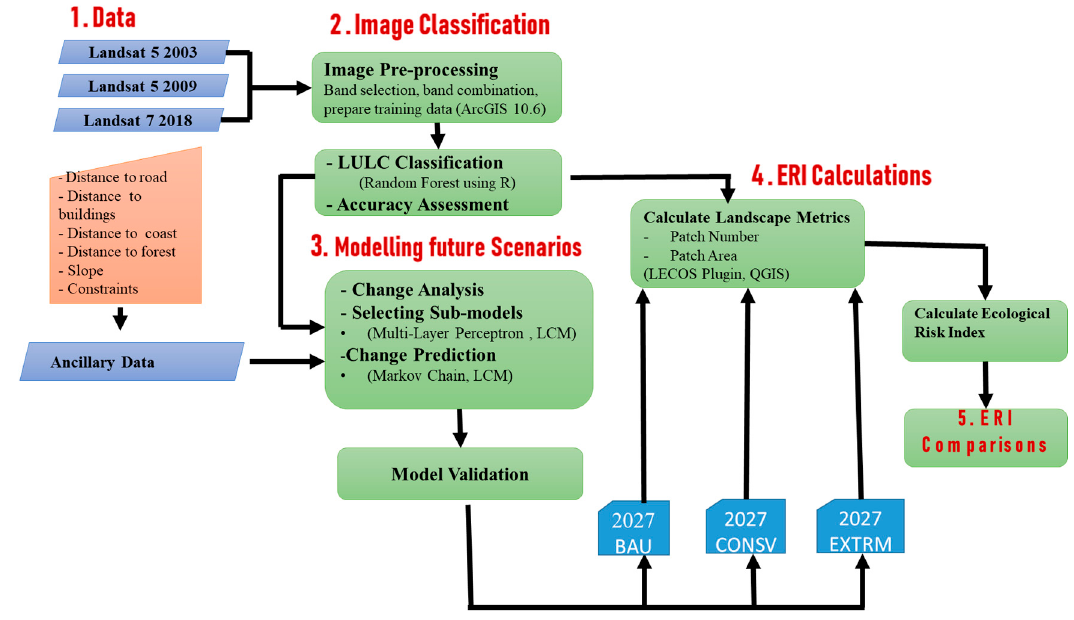
Figure 2. Methodological framework.